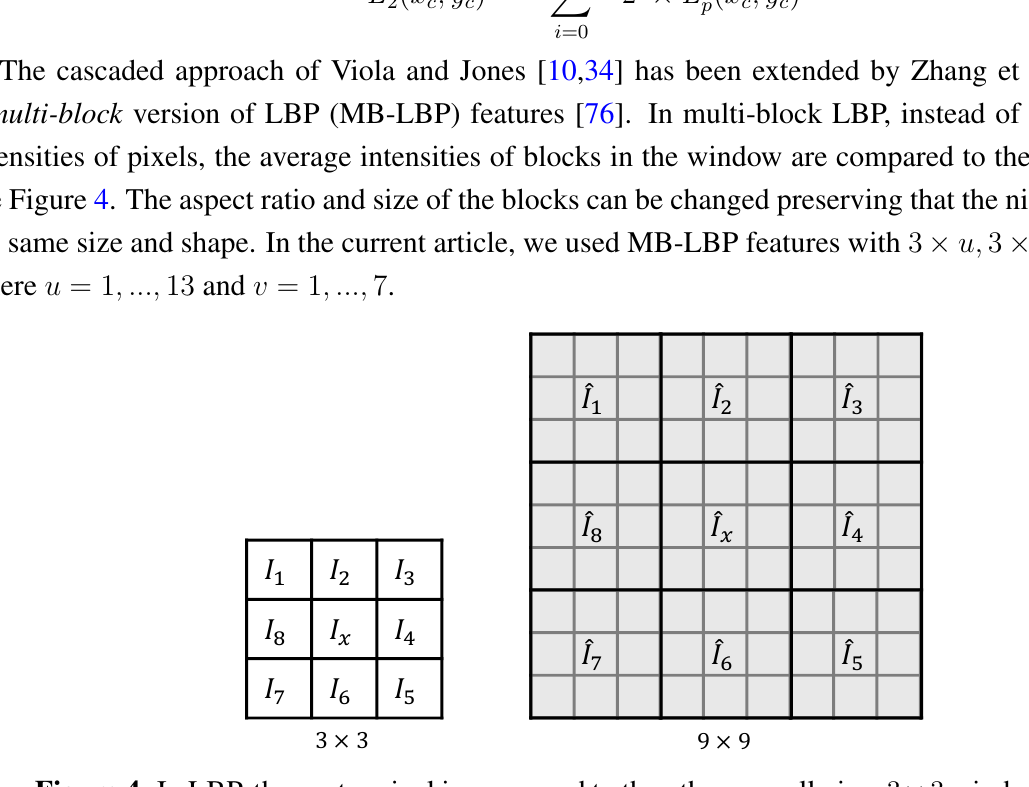
Figure 4. In LBP, the center pixel is compared to the others usually in a 3 × 3 window ( Left ). In the multi-block version ( Right ), average intensities in the blocks are compared